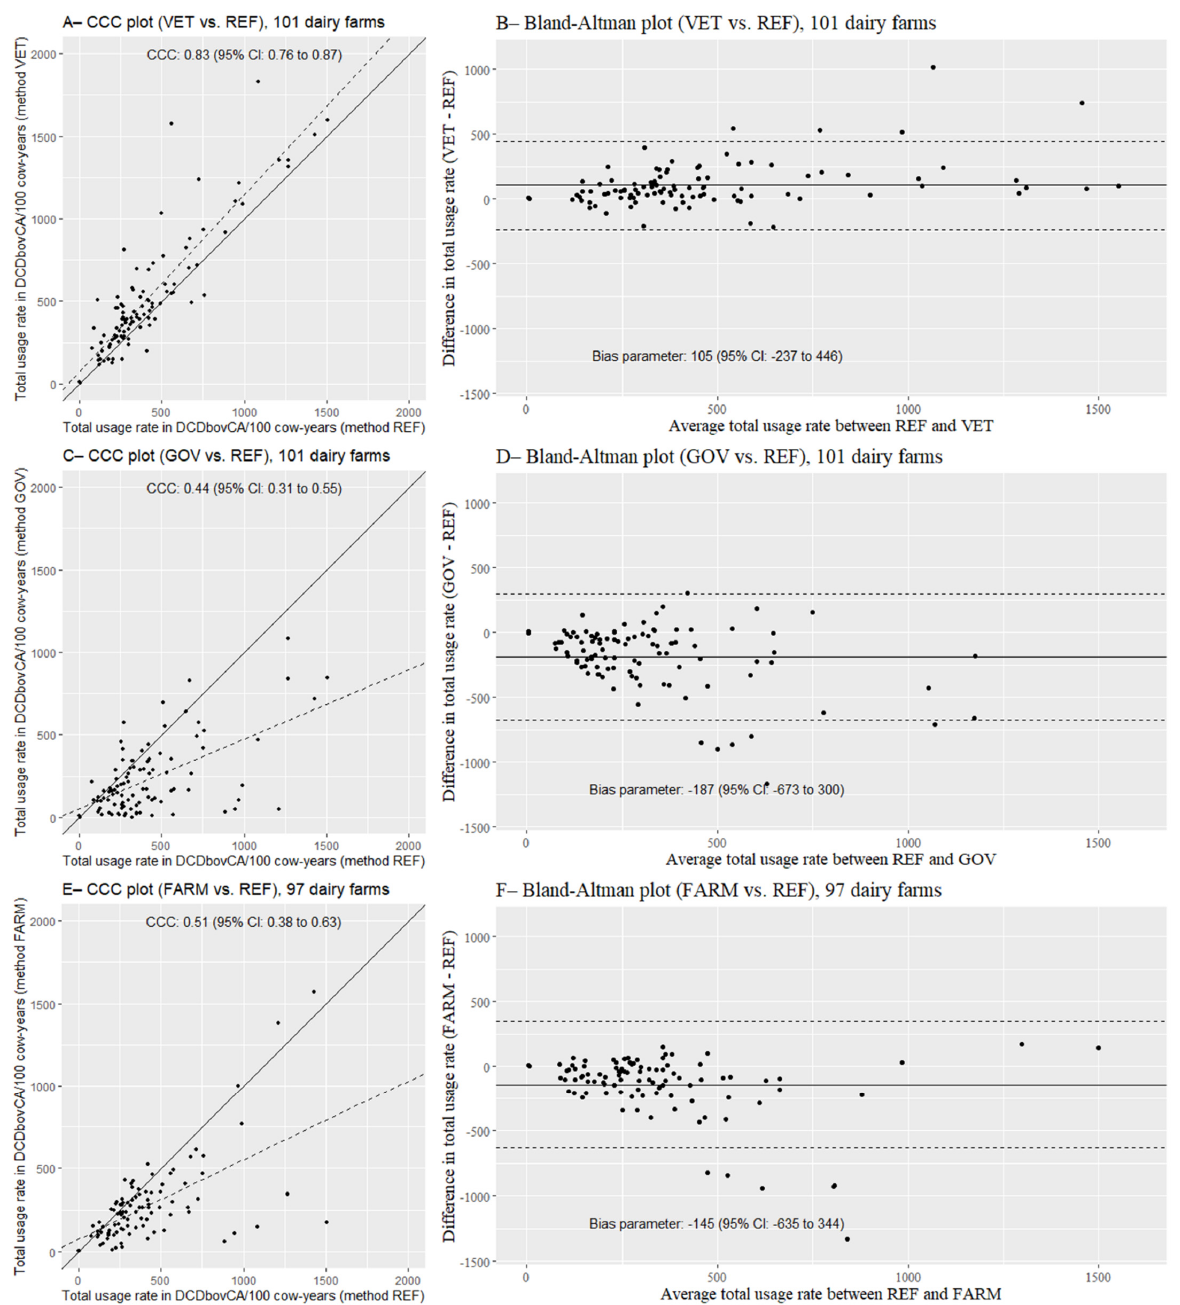
Figure 2. Concordance plots (concordance correlation coefficient (CCC) plots) and Bland–Altman plots showing agreement in quantification of the total usage rate of antimicrobial agents in products other than medicated feed (in DCDbovCA/100 cow-years) between a garbage can audit (REF method) and alternative methods using veterinary invoices (VET method; A , B ), a governmental database (GOV method; C , D ), and farm treatment records (FARM method; E , F ). Each black point represents one farm of the project (101 farms in A – D , 97 farms in E , F ). In CCC plots, the solid and dashed lines represent, respectively, the line of perfect concordance and the reduced major axis; concordance correlation coefficients (CCC) are presented with their 95% confidence interval (95% CI). In Bland–Altman plots, the solid line and the dashed lines represent, respectively, the mean difference (estimated bias) and the 95% limits of agreement; the mean difference between the REF method and the alternative method is presented with its 95% confidence interval (95% CI).